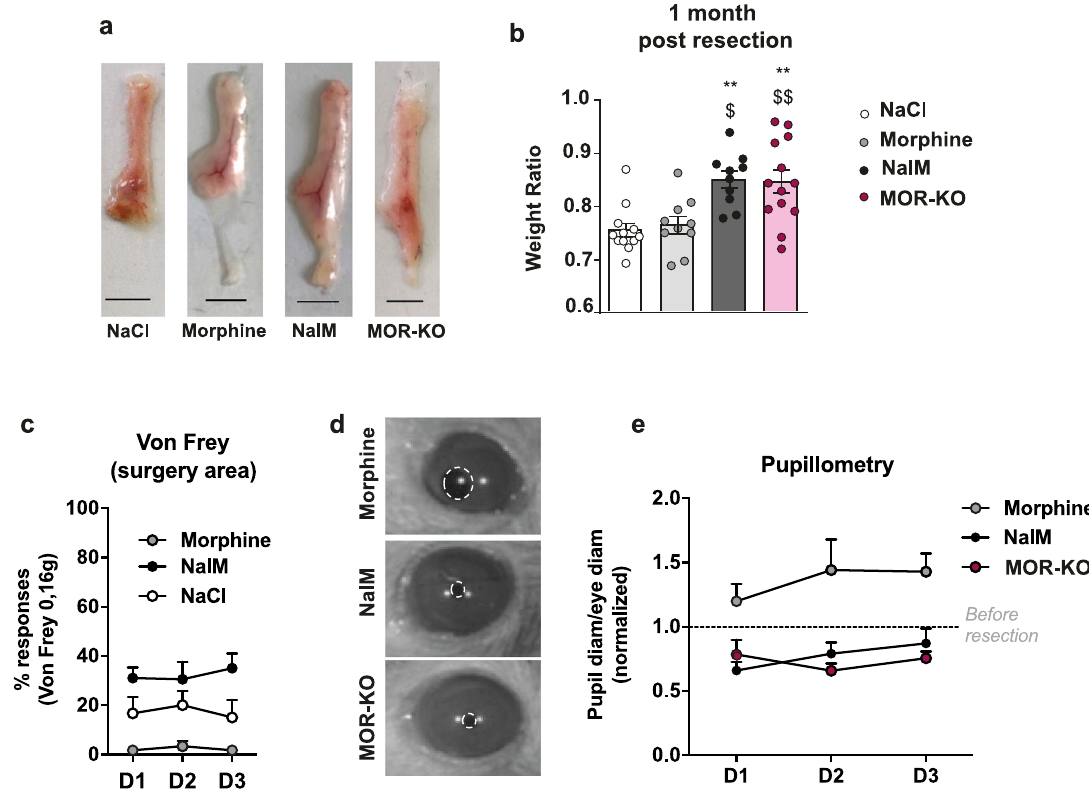
Fig. 1 MORs mediate the deleterious effect of opioids on regenerative process. a Representative pictures of scAT 1 month after resection, in C57Bl/6 mice treated with NaCl, morphine or NalM, and in MOR-KO mice (scale bars: 0.5 cm). b Quanti fi cation of regeneration. Weight ratio 1 month post-resection ( n = 10 – 13 per group). c Quanti fi cation of nociceptive sensitivity using von Frey test. Mean frequency (±SEM) of withdrawal re fl ex after stimulation of the surgery area from day 1 (D1) to day 3 (D3) post-resection ( n = 6 – 10 per group). d Representative pictures of pupils of C57Bl/6 mice treated with NalM or morphine, and of MOR-KO mice. e Quanti fi cation of nociceptive sensitivity using pupillary re fl ex test. Diameter ratio from day 1 (D1) to day 3 (D3) post-resection ( n = 5 – 8 per group). NalM: naloxone methiodide. (* ,$ p < 0.05, ** ,$$ p < 0.01. *: vs. NaCl, $: vs.